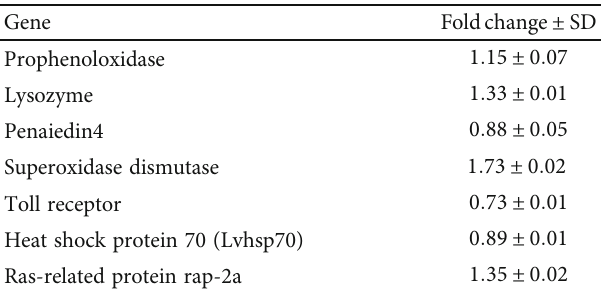
Table 7: Fold change in expression levels (mean ± SD) of tested genes for white leg shrimp L. Vannamei reared under stocking density of 100 org. /m 2 under bio fl oc system compared to of higher density (300 org./m 2 ) control